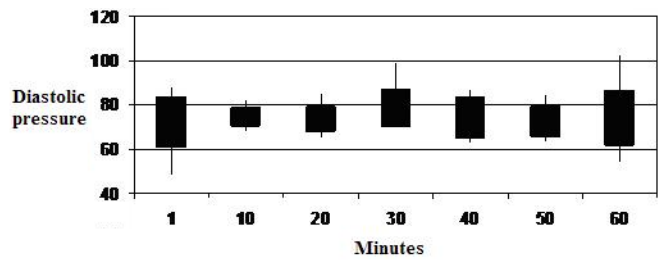
FIGURE 6 - Diastolic Pressure during